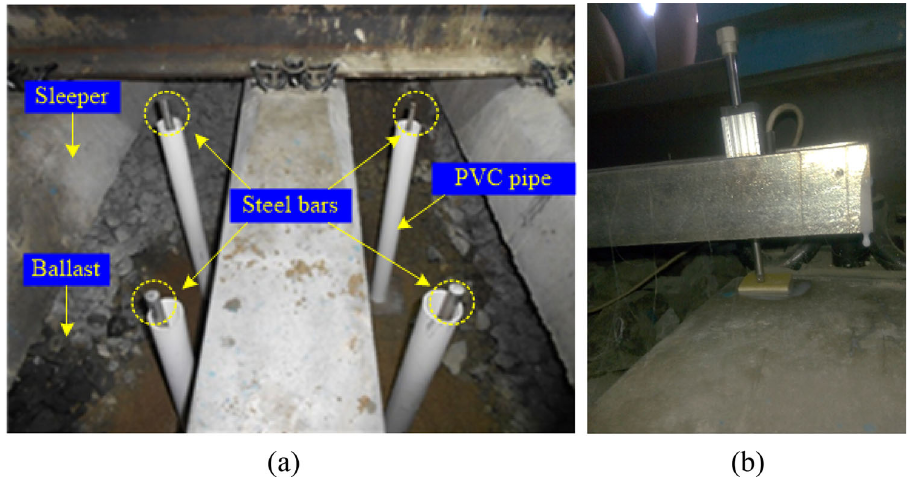
Fig. 12 Sensor layout process in ballasted track: a device for measuring subgrade displacement; b displacement sensor of measurement range of 0.2 MPa are only used in the topside design scheme in Fig. 5, the pressure sensors are laid totally in six different layers in the subgrade, including the layer, while sensors with the measurement range of top layer and the bottom layer. The sensors with the 0.1 MPa are employed in the other layers.